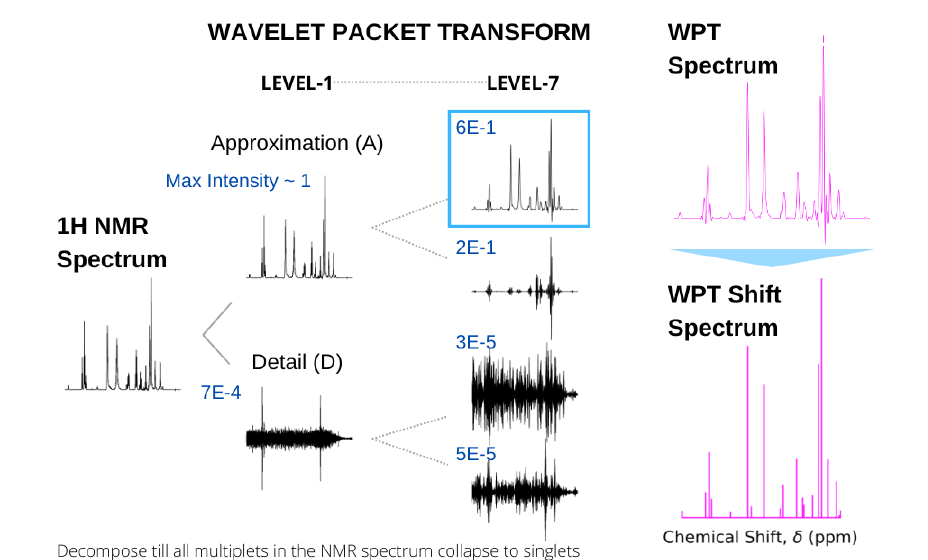
Figure 6. Conversion of the 500 MHz 1 H NMR spectrum of glutathione (left) to WPT and WPT shift spectra (right). In calculating the WPT shift from the WPT spectrum, only the peaks above a threshold were taken into consideration. The wavelet decomposition at Level 1 and Level 7 by the Daubechies-9 wavelet (Db9) is shown, and the maximum amplitudes of each of the components are given in blue. A decomposition at Level 7 was selected, where all the multiplets in the original NMR spectrum were reduced to